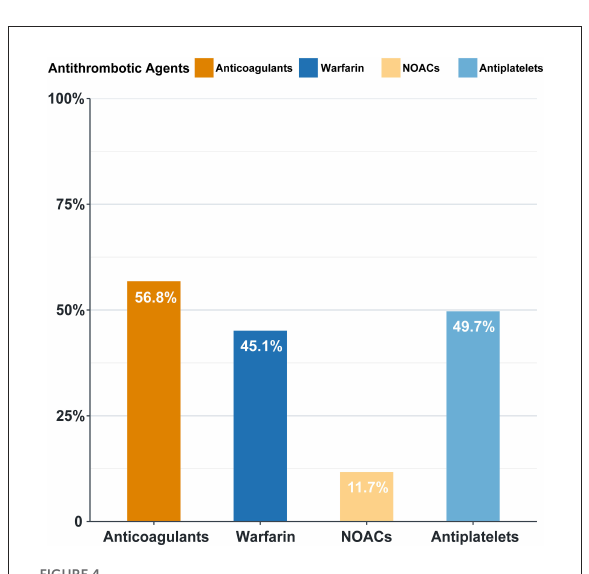
FIGURE4 Antithrombotic agent prescription in patients with intraxardiac thrombus (%). NOACs, non-vitamin K antagonist oral anticoagulants, including rivaroxaban, dabigatran, and apaxiban. Antiplatelets: including aspirin and